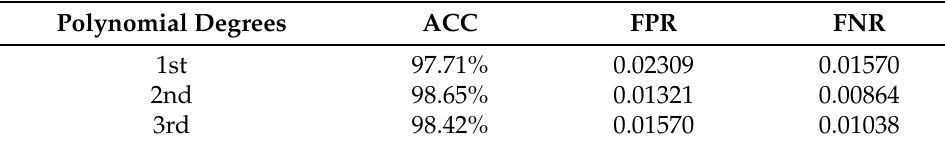
Table 5. The results of different polynomial degrees on